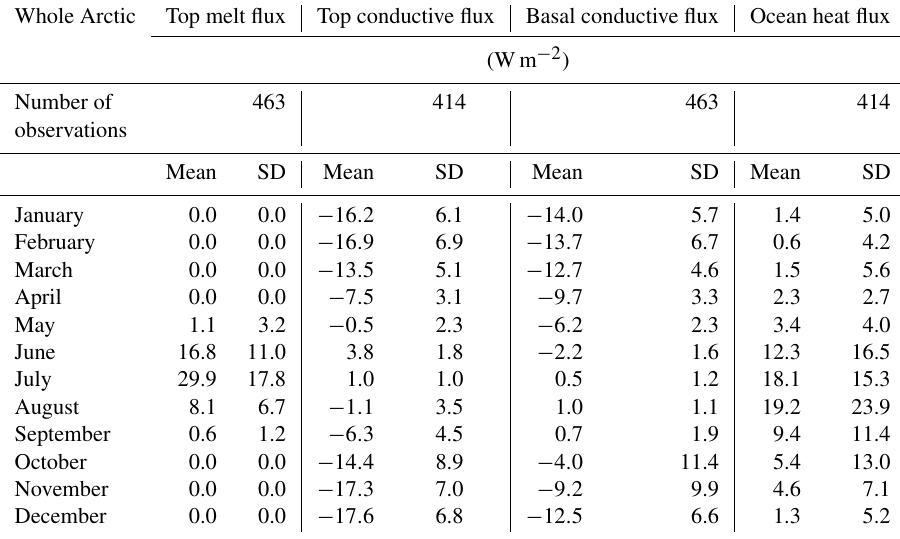
Table 1. Mean and standard deviations of fluxes measured from the IMB data (in Wm − 2 ), in each month of the year. For each flux, the convention is that downwards indicates